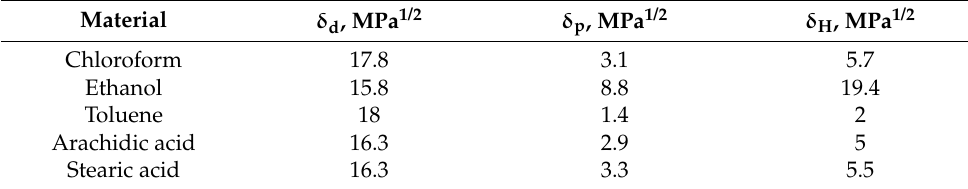
Table 3. Hansen solubility parameters for vapors of chloroform, toluene, ethanol, as well as arachidic and stearic acids [41,42].